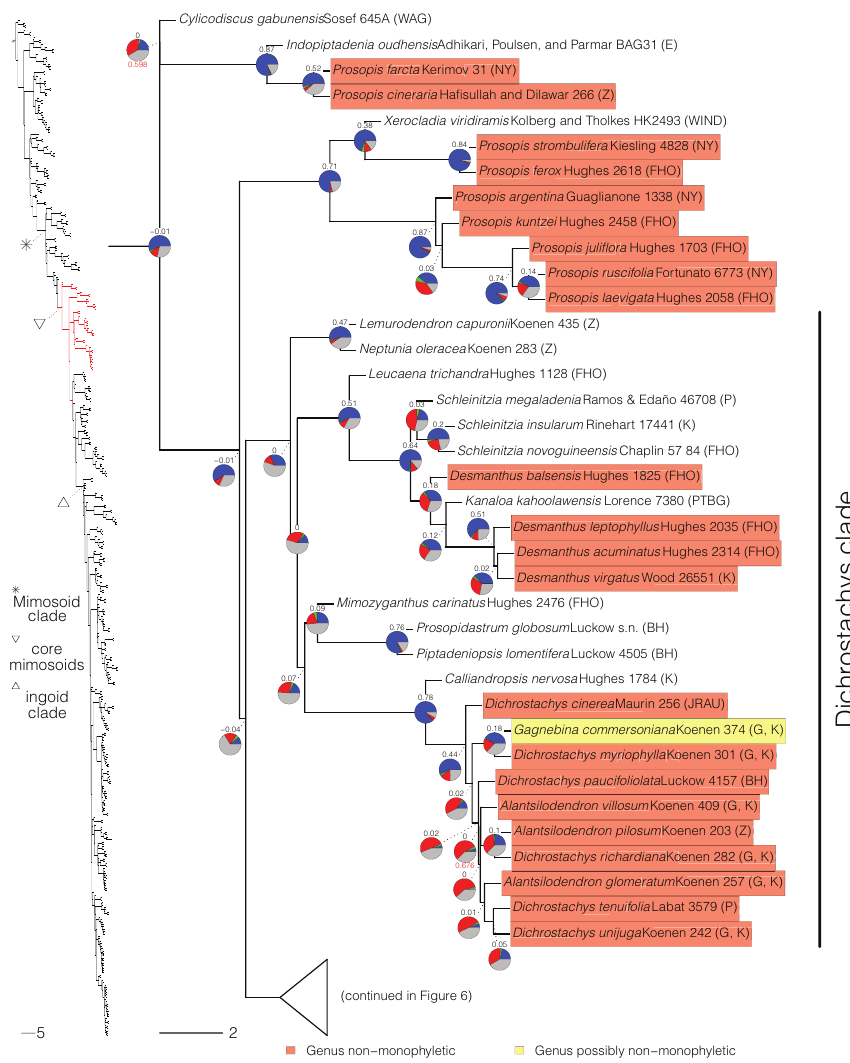
Figure 5. Phylogeny of Caesalpinioideae (continued). See Fig. 2 for